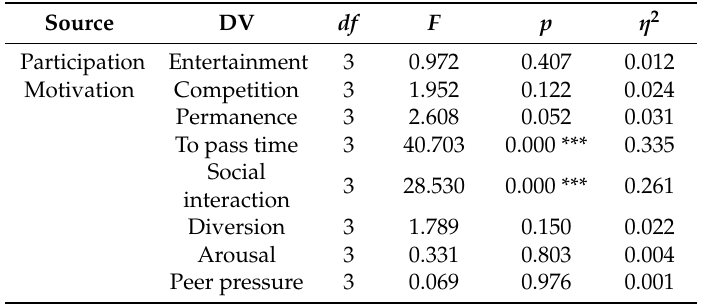
Table 6. Results of MANOVA: Differences in participation motivations in esports between four groups based on the forms of families.